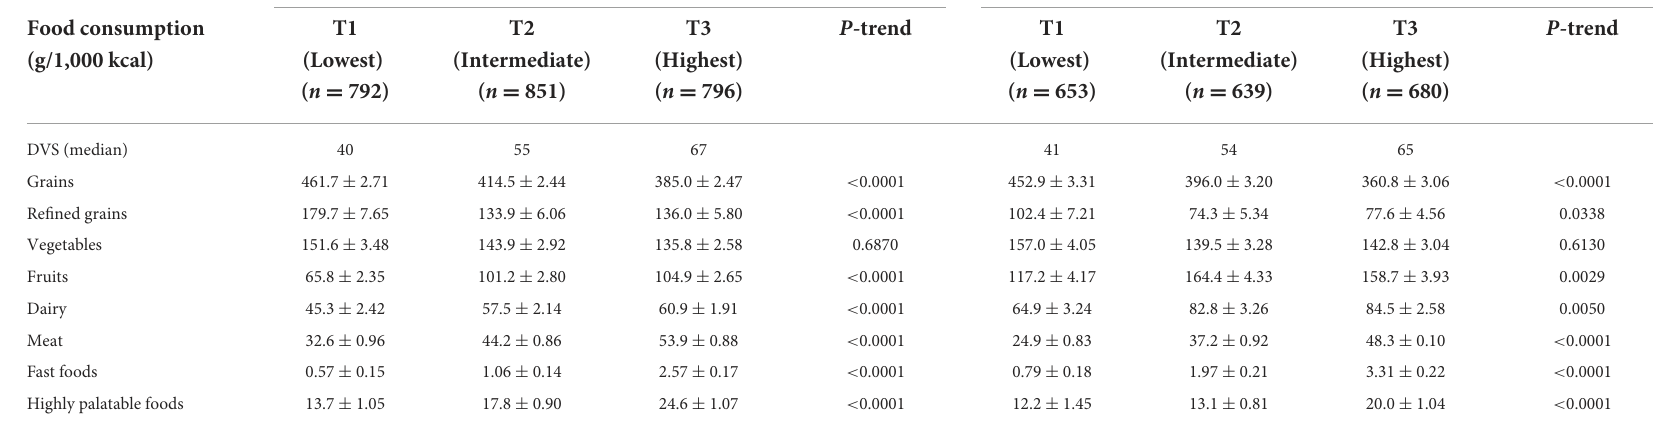
TABLE 3 Food consumption according to dietary variety